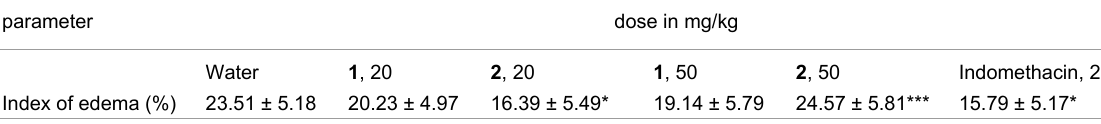
Table 4: Anti-inflammatory effect of compounds 1 and 2 (oral administration).